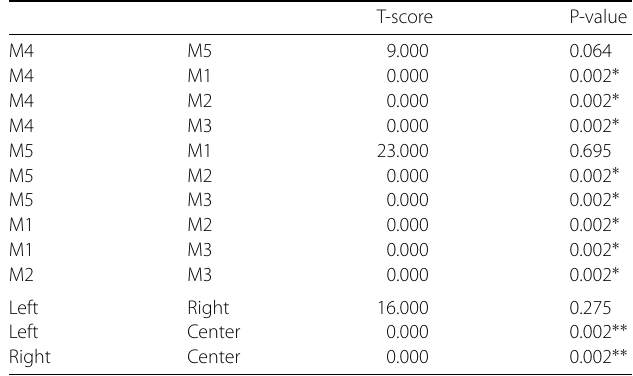
Table 8 Results for the corrected paired t-tests for ideological leaning